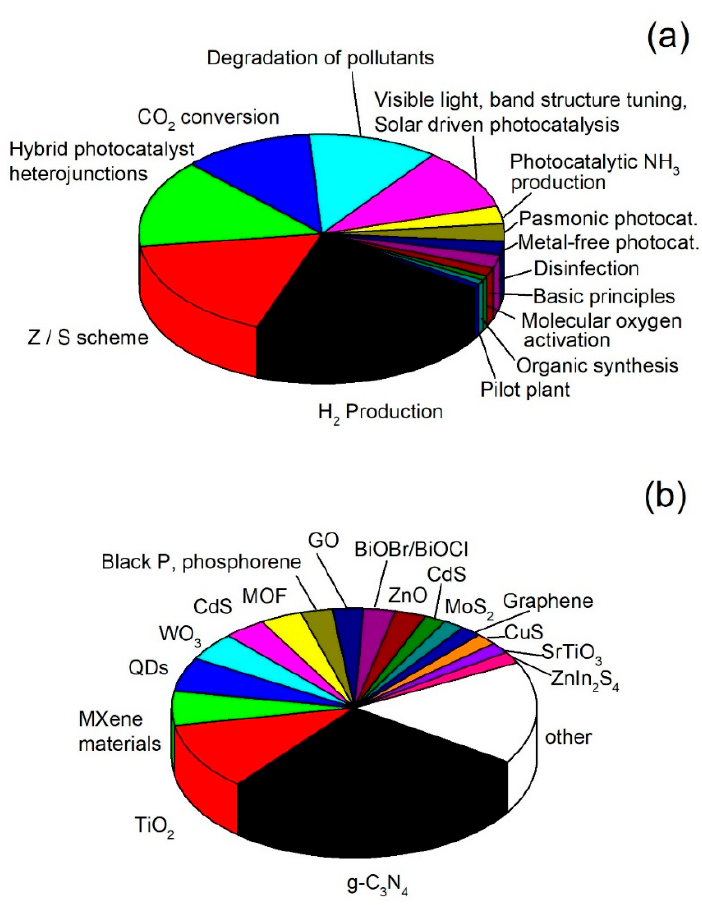
Figure 5. Evaluation of the main topics ( a ) and most-investigated materials ( b ) in the field of photocatalysis in the period 2017–2021.